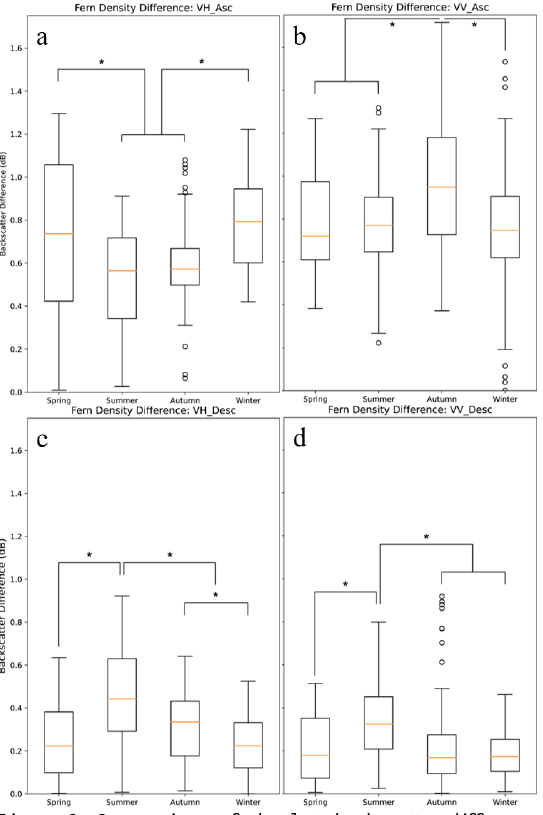
Figure 6: Comparison of absolute backscatter difference between seasons and different acquisition scenarios, asterisk represents statistical significance (p < 0.05).